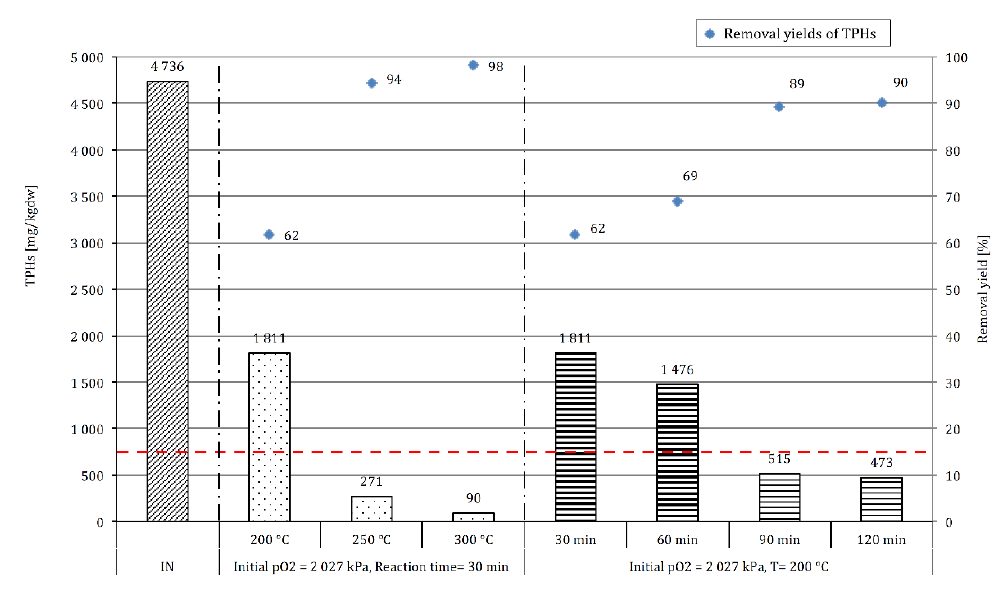
Figure 3. Results obtained for soil #2. Initial pO 2 = initial partial pressure of oxygen fed into the reactor. Dotted line represents the limit (750 mg(TPHs) · kg dw − 1 ) imposed by Italian law for the reuse of the treated soil [36].